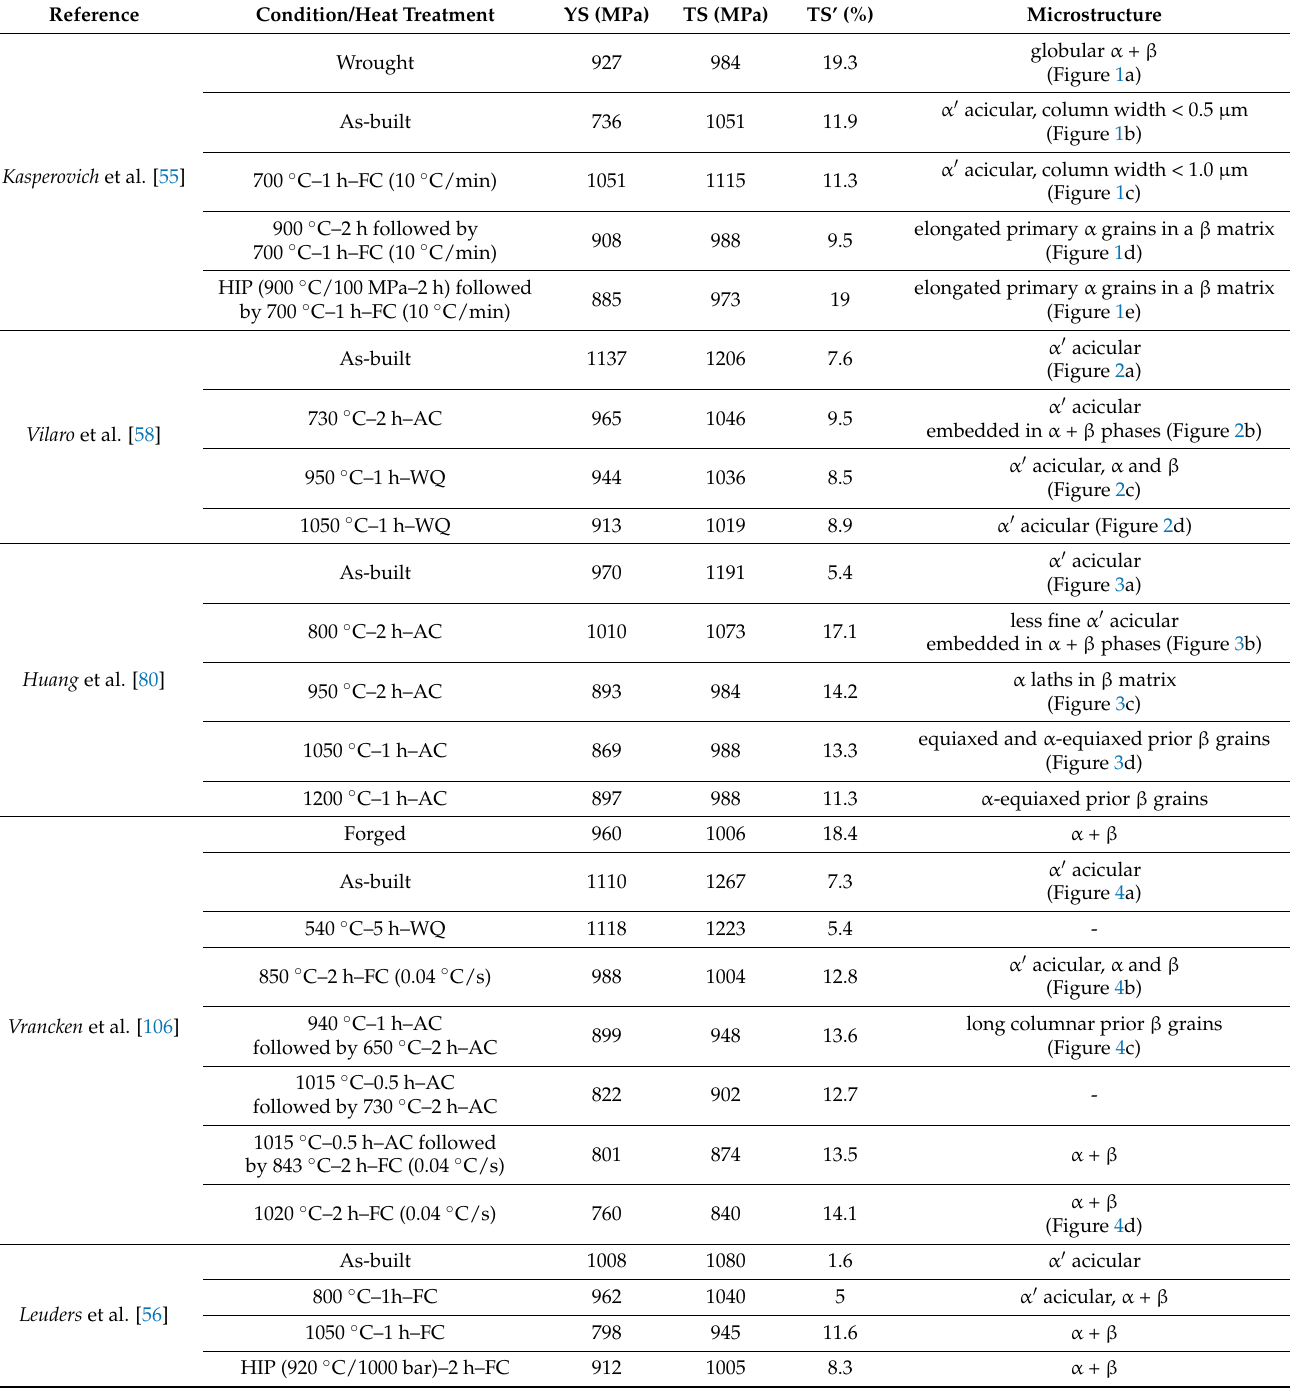
Table 4. Overview of the microstructure and mechanical properties before and after heat treatments on LPBF Ti6Al4V: YS = yield strength; TS = tensile strength; TS’ = tensile strain; WQ = water quenching (>410 ◦ C/s); AC = air cooling; FC = furnace